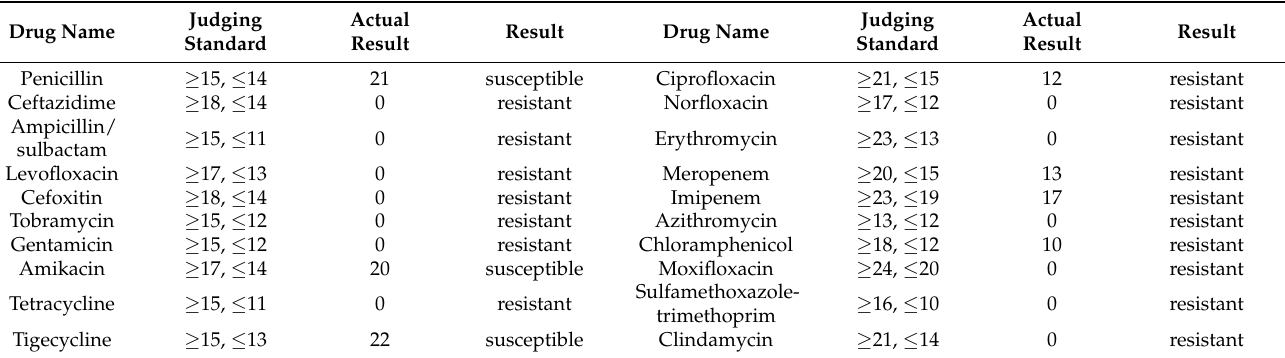
Table 4. Results of the drug sensitivity test (K-B method).